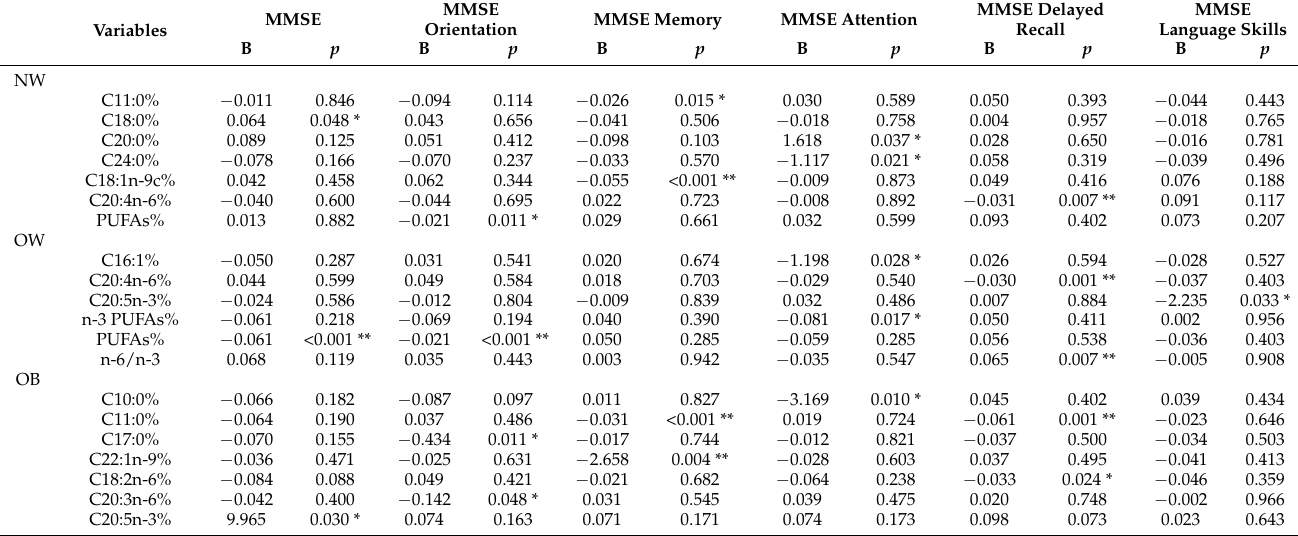
Table 5. Associations between the scores in all of the cognitive domains measured by MMSE and the fatty acid composition of the erythrocyte membranes in the three groups.